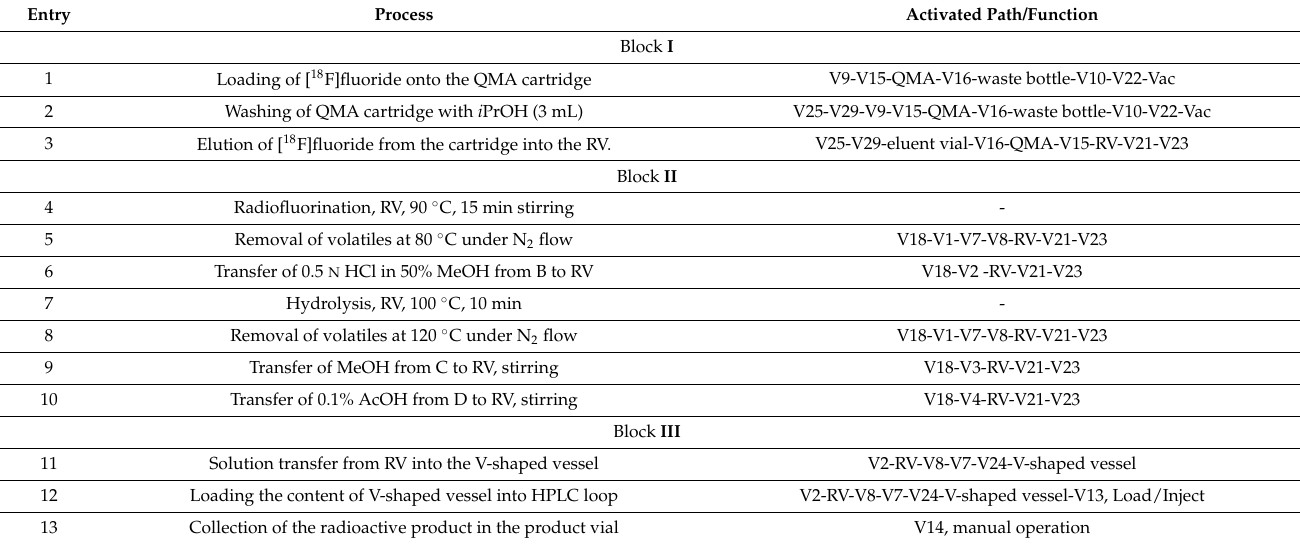
Table 2. Process sequence for the automated synthesis of 6- L -[ 18 F]FMT using the modified GE Tracerlab FX C Pro module (Figure 5).